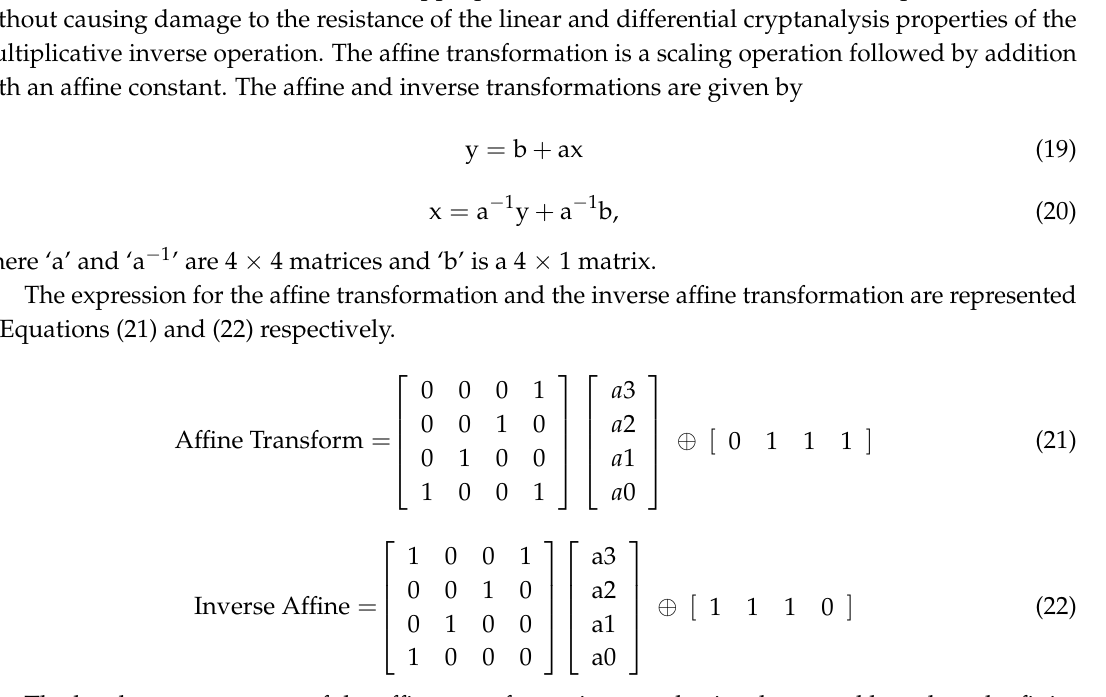
Figure 3. Squarer/Fermat inversion in the composite field GF ((2 2 ) 2 ) . Fermat’s inversion and the squarer have a similar structure in GF ((2 2 ) 2 ) and employ only a single XOR gate.